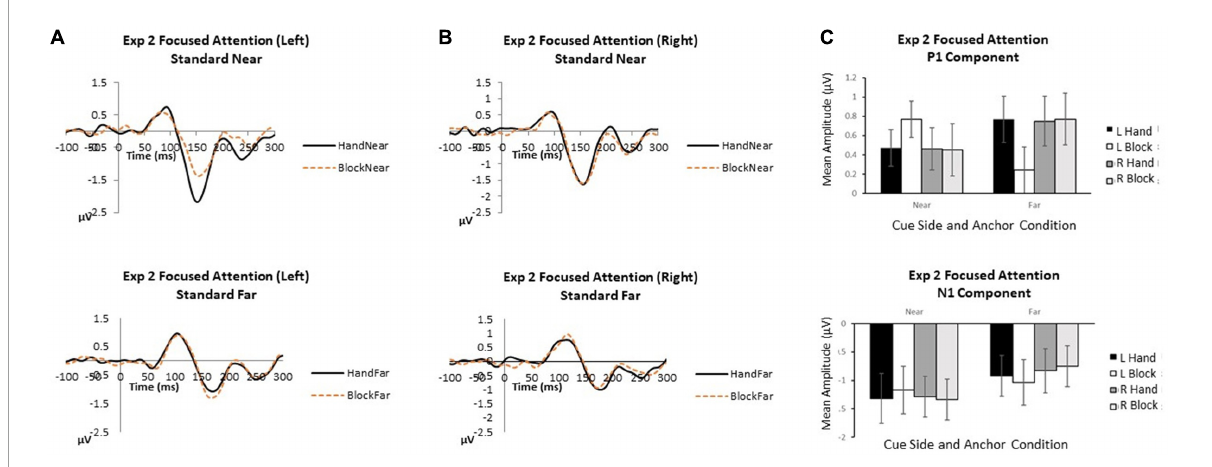
FIGURE3 Experiment 2 focused attention. (A) Grand average waveforms for focused attention to the left in near and far locations. (B) Grand average waveforms for focused attention to the right in near and far locations. (C) P1 and N1 mean amplitudes by cue side, anchor type and anchor proximity. Error bars represent standard